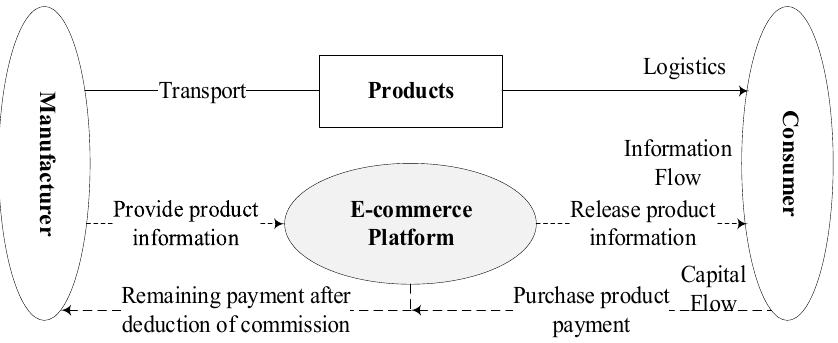
Figure 1. The model structure of the low-carbon e-commerce supply chain (LCECSC).